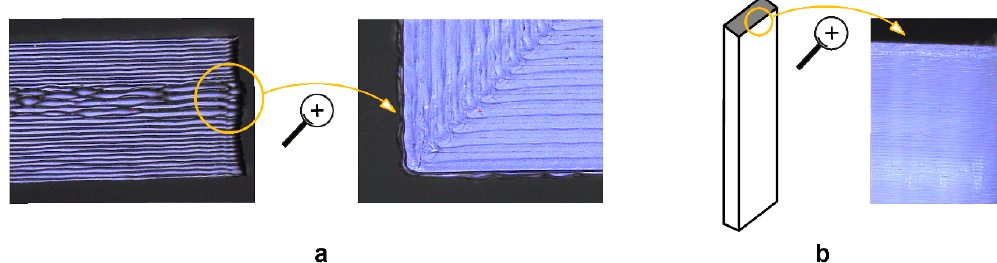
Figure 9. ( a ) Details of deformed layers and filaments for flat orientation. ( b ) Crystallized areas in upright orientation. Polymers 2019 , 10 , x FOR PEER REVIEW Table 6. Average dimensional accuracy results of PLA, PLA 3D850 and PLA-Graphene samples as a function of build orientation and the type of material. The results of three samples of each set are shown for comparative purposes. Maximum and minimum dimensional deviation of each sample are depicted in brackets.